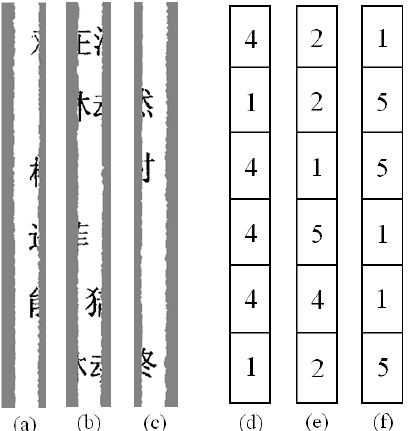
Figure 4. Leftmost piece, middle piece, rightmost piece, and their corresponding digital sequences: ( a ) leftmost piece and ( d ) corresponding digital sequence; ( b ) middle piece and ( e ) corresponding digital sequence; ( c ) rightmost piece and ( f ) corresponding digital sequence.